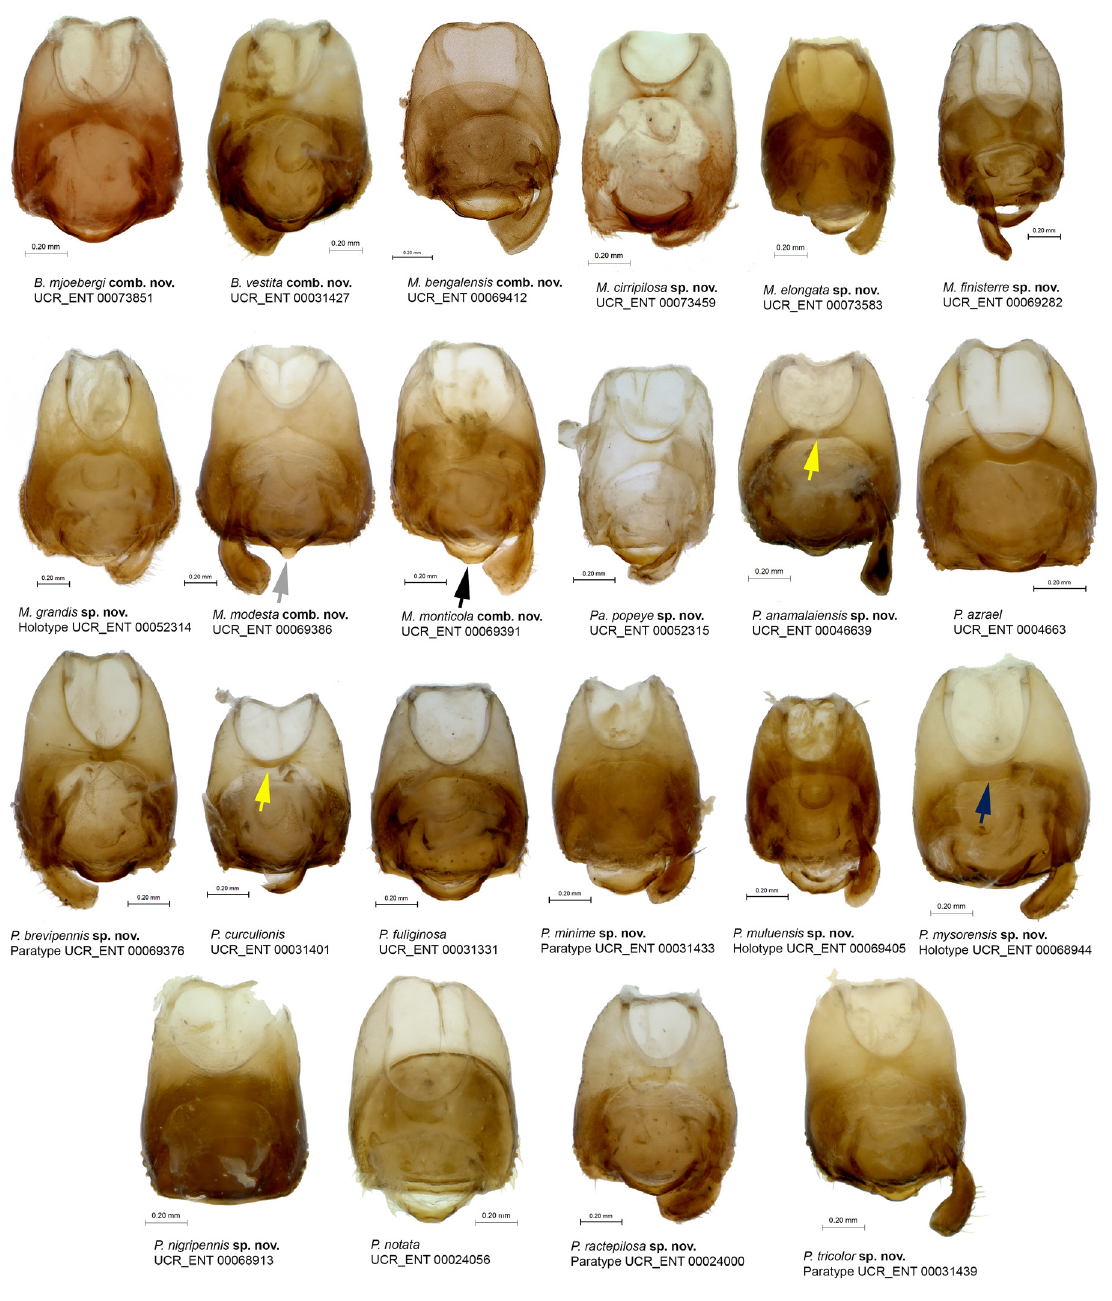
Fig. 8. Dorsal view of the male pygophore in species of Breviphysoderes gen. nov., Macrophysoderes gen. nov., Paraphysoderes Villiers, 1962 and Physoderes Westwood, 1845. For an explanation of the colored arrows, see keys on pages 37 and